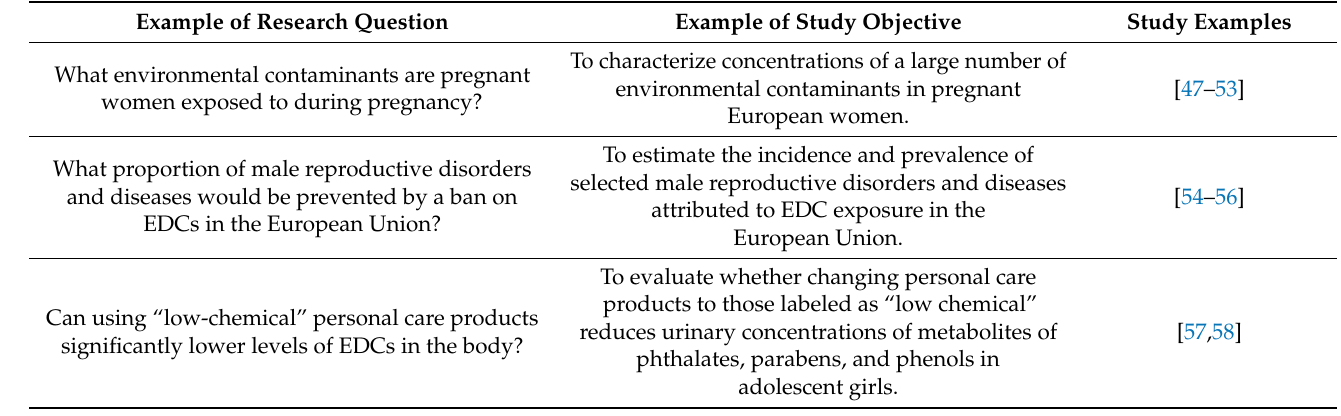
Table 2. Example of descriptive, causal, predictive, and evaluative questions in epidemiologic studies on